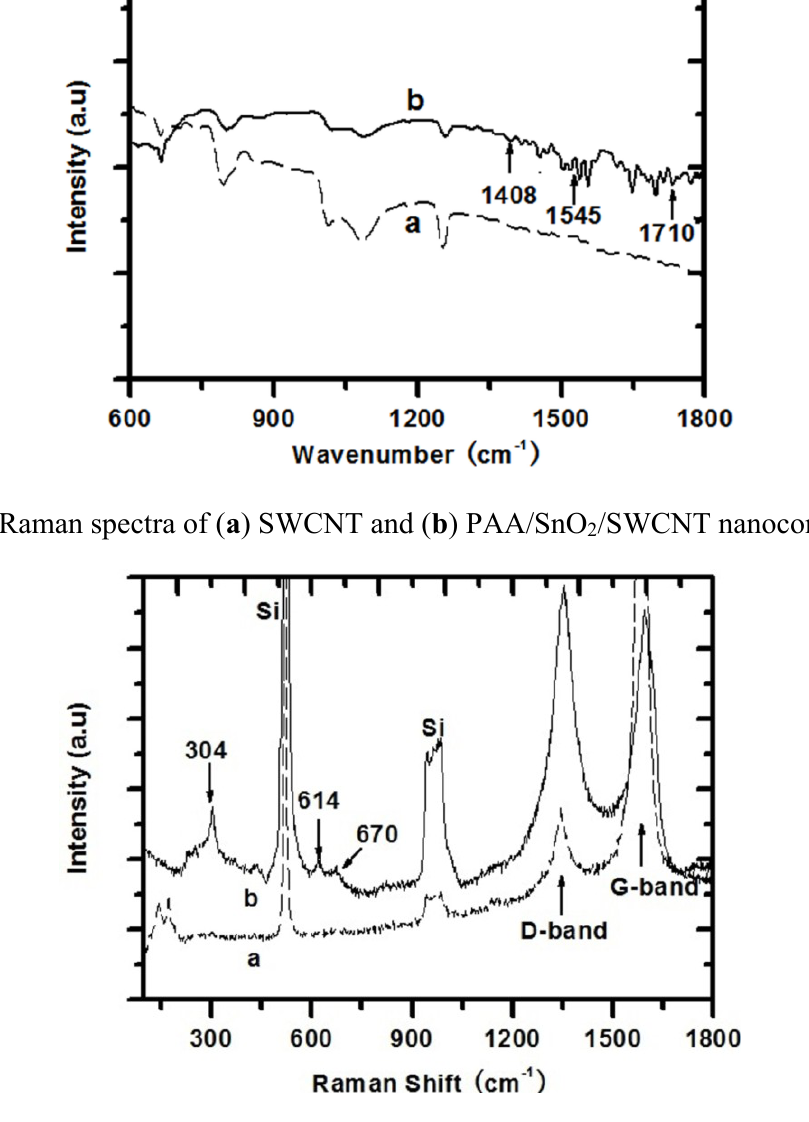
/SWCNT nanocomposites. 2